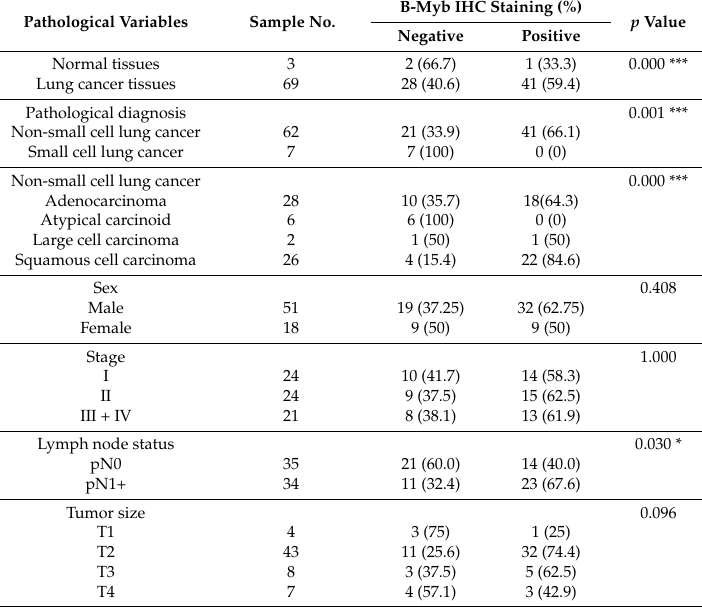
Table 1. Expression of B-Myb in lung cancer determined by immunohistochemistry. B-Myb IHC Staining (%) Pathological Variables Sample No.